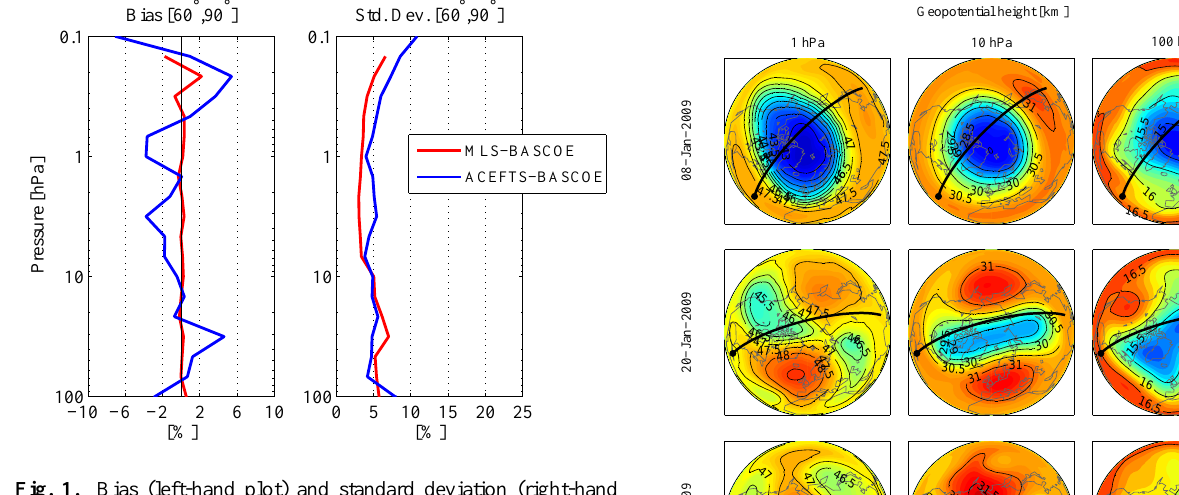
Fig. 1. Bias (left-hand plot) and standard deviation (right-hand plot), as a percentage of the observational data, between BASCOE water vapour analyses and MLS water vapour observations (red line), and between BASCOE water vapour analyses and ACE-FTS water vapour observations (blue line). Statistics are computed for the period January–February 2009 and over 60 ◦ N–90 ◦ N (see text for further details). The x-axis is percent difference (%); the y- axis is pressure (hPa). Positive values in the bias indicate that the BASCOE analyses are moister than the MLS and ACE-FTS data. To orient the reader, a rough equivalence between pressure levels and isentropic levels is as follows: 50hPa (550K); 10hPa (850K); 1hPa (1900K).